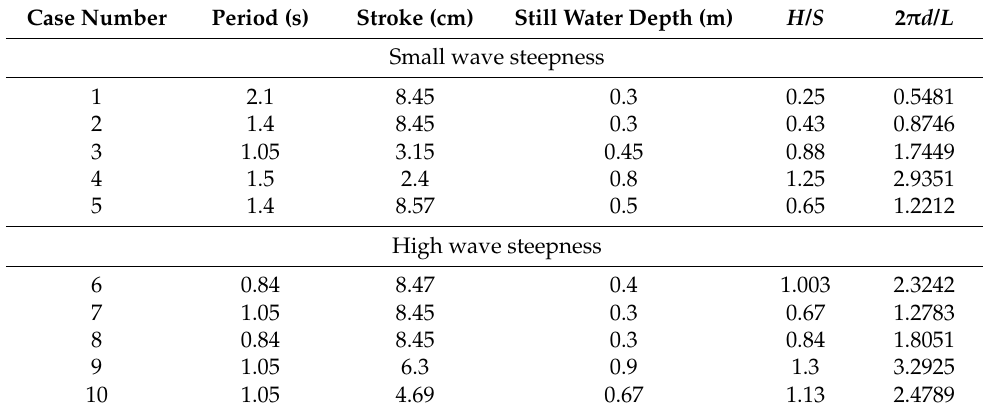
Table 2. Validation results.